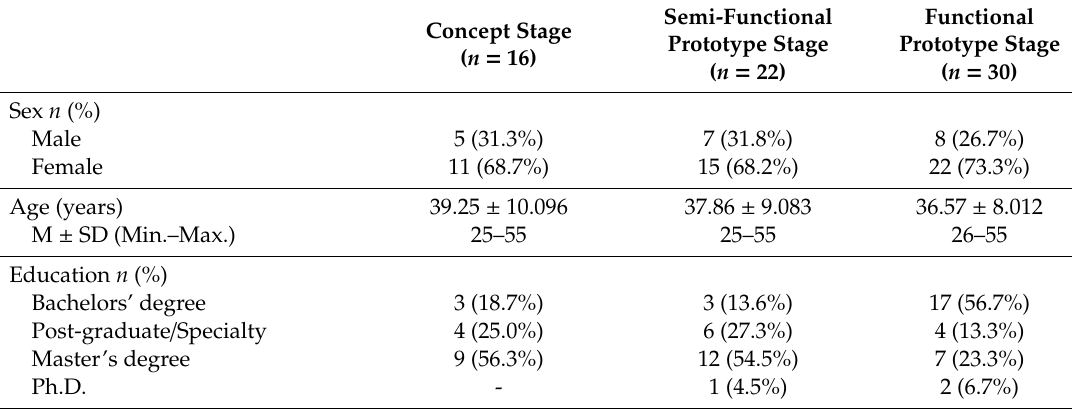
Table 1. Focus Groups: Users’